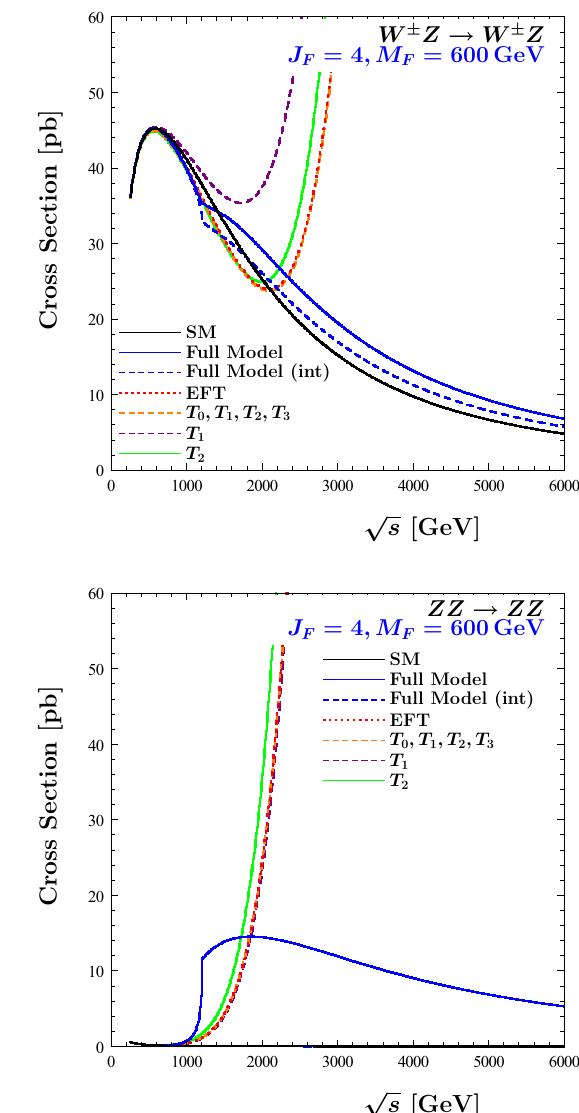
Fig. 5 Unpolarized V V → V V cross sections as a function of the √ s = m VV for same-sign WW scattering (upper left), COM energy W Z -scattering (upper right), the WW → Z Z process (lower left) and Z Z -scattering (lower right). BSM curves are for the case of a single fermion multiplet with J F = 4 , M F = 600GeV. The diverging curves